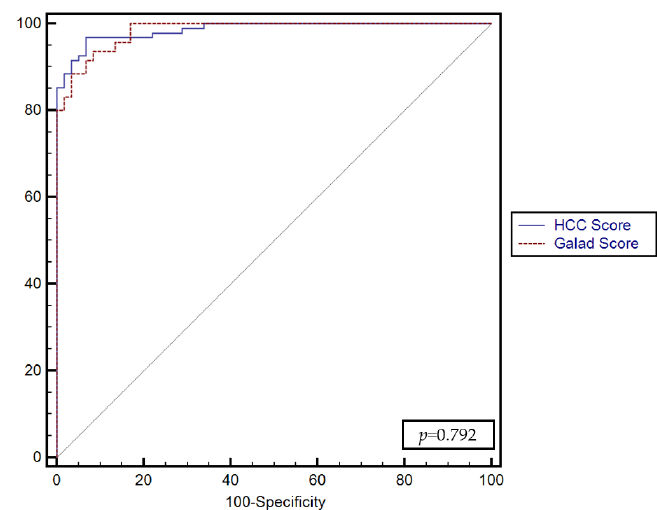
Figure 4. Comparison between the performance of the GALKA and GALAD scores for predicting the presence of